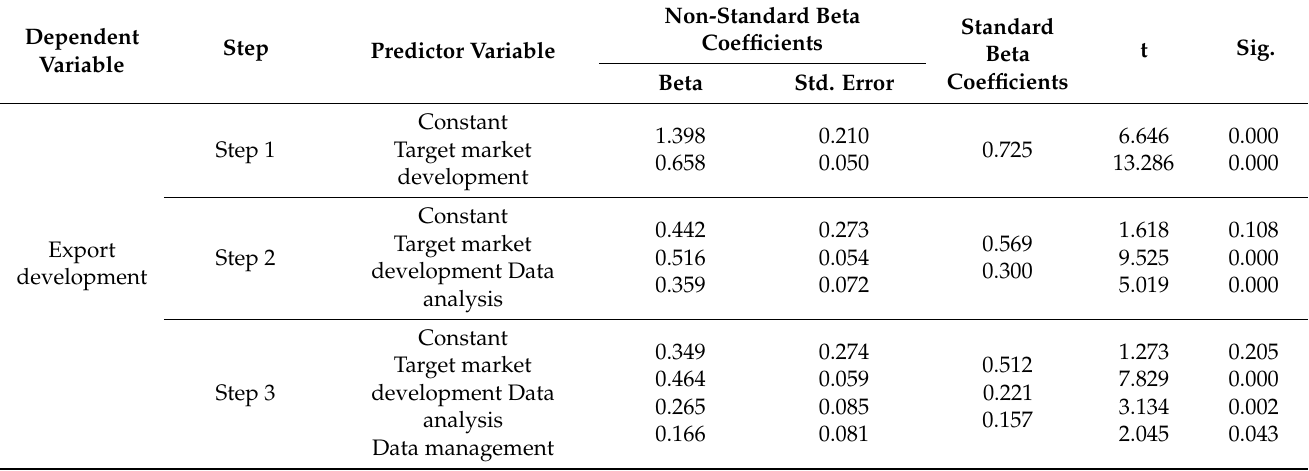
Table 6. The beta coefficient in forecasting export development by applying business intelligence